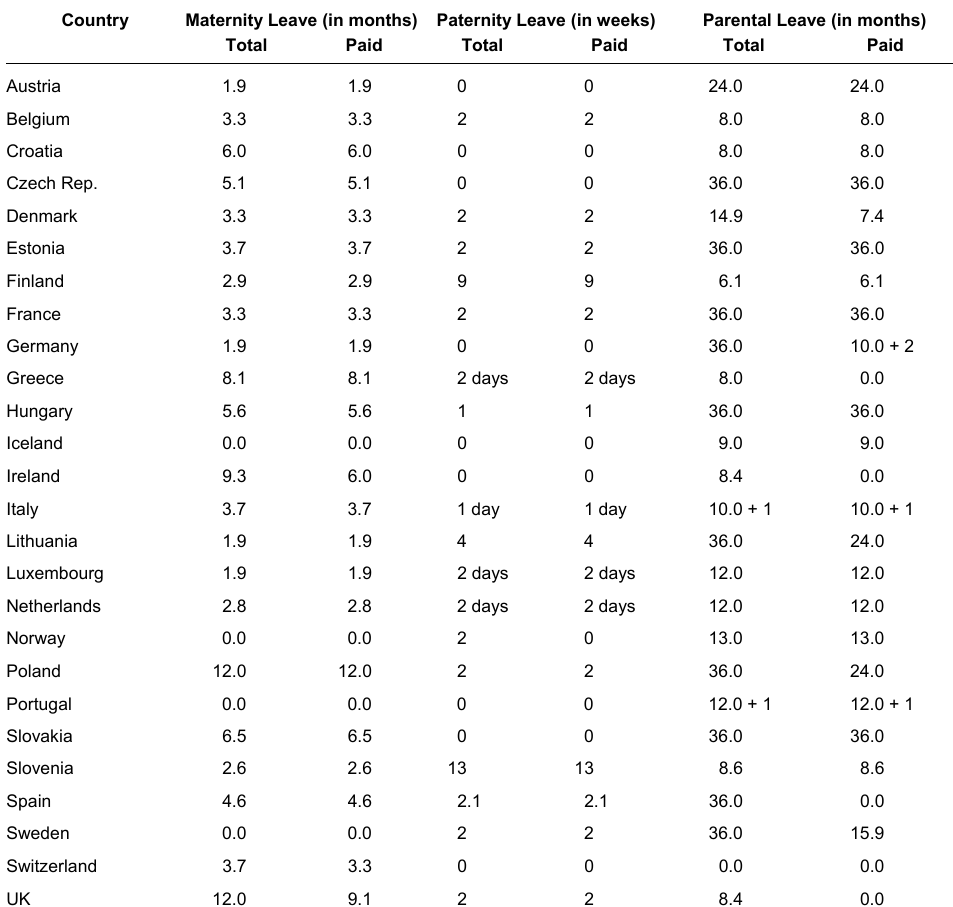
Table 1 : Parental leave policies in European countries